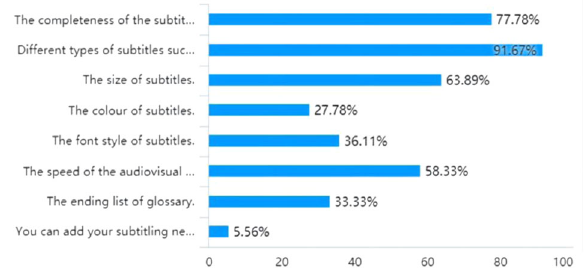
Fig. 4 Selections of personalised subtitled options. This fi gure underlines the customisable subtitling settings to which the students aspire. For more details of the customised features that have not been shown fully due to the spatial constraints in the fi gure, please consult Appendix